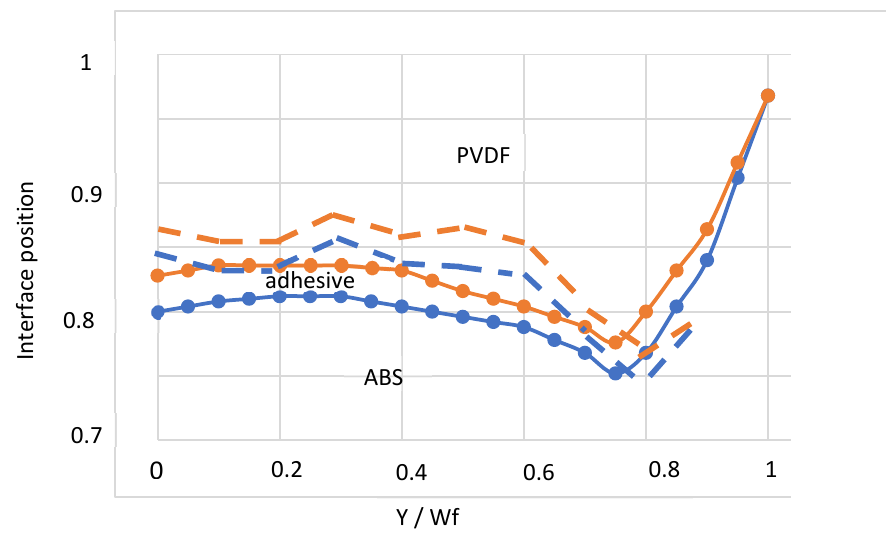
Figure 25. Polymer distribution at die exit: ( - - - ) computation: ( • − • ) experience. The interface positions ( α 1 , α 2 ) are restricted to 0.7 < α < 1 in order to visualize the very thin adhesive layer (Adapted from Ref. [14]).